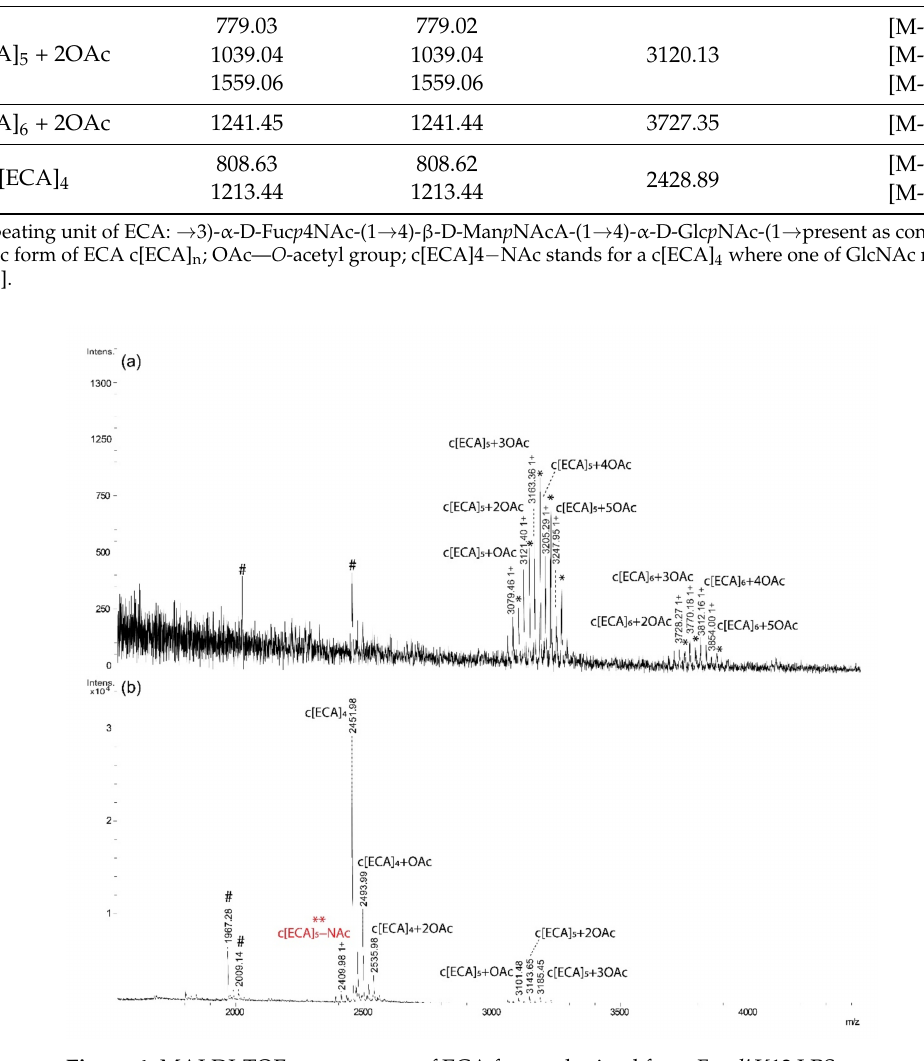
Figure 4. MALDI-TOF mass spectra of ECA forms obtained from E. coli K12 LPS supernatant acquired in positive ion mode for ( a ) fraction II; and ( b ) fraction III. [ECA], trisaccharide repeating unit